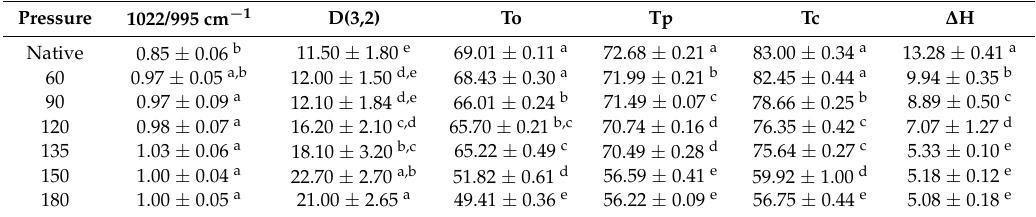
Table 1. Thermal properties, particle size and Fourier transformed infrared spectroscopy (FTIR) ratio of Native and pressurized LS.